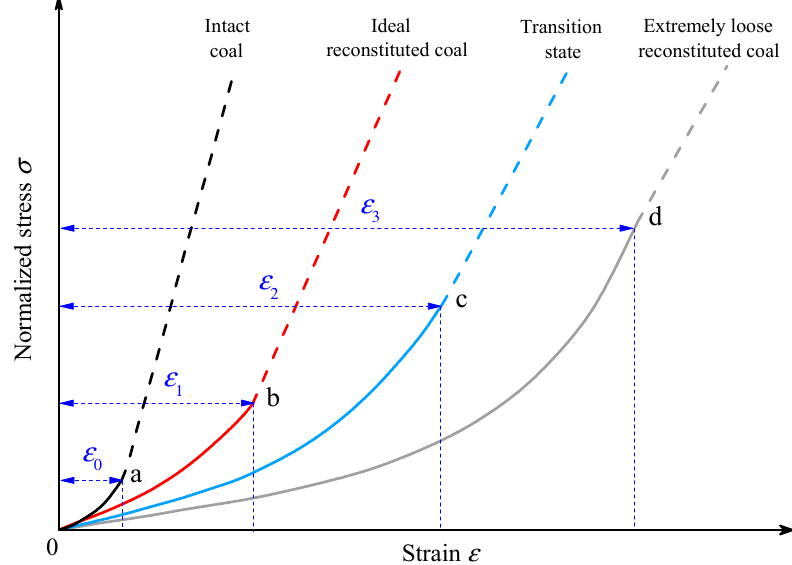
Figure 12. The stress-strain comparison diagram of RTC.